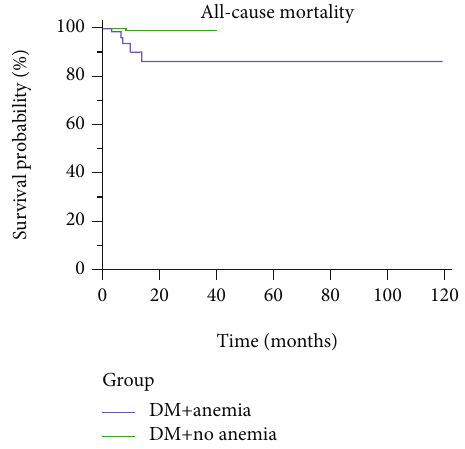
Figure 2: Cumulative survival probability of the anemic and nonanemic diabetic